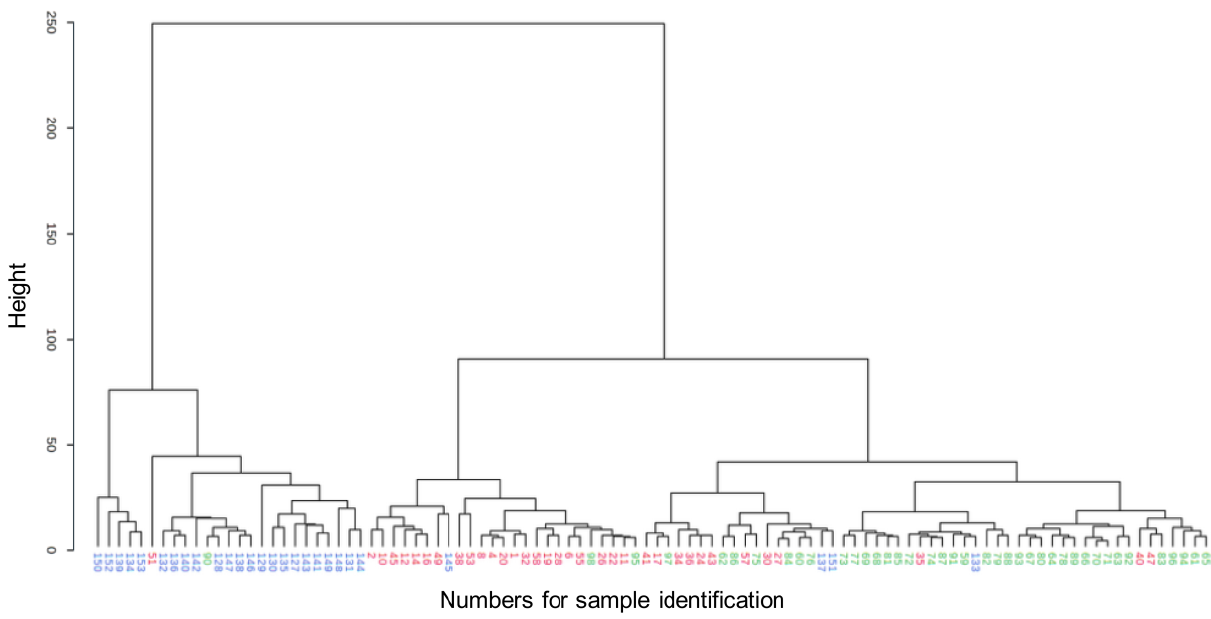
Figure 2. Dendrogram of hierarchical cluster analysis of serum metabolomics data from canine samples of either hyperadrenocorticism untreated (HYPER U , blue, n = 27), hypoadrenocorticism untreated (HYPO U , red, n = 35), and control (CONT, green, n = 40) groups. Each number on the x-axis reflects one serum sample. The y-axis shows the similarity levels expressed as Euclidean distances. Horizontal and vertical lines depict clustering of samples and differences in the distances,